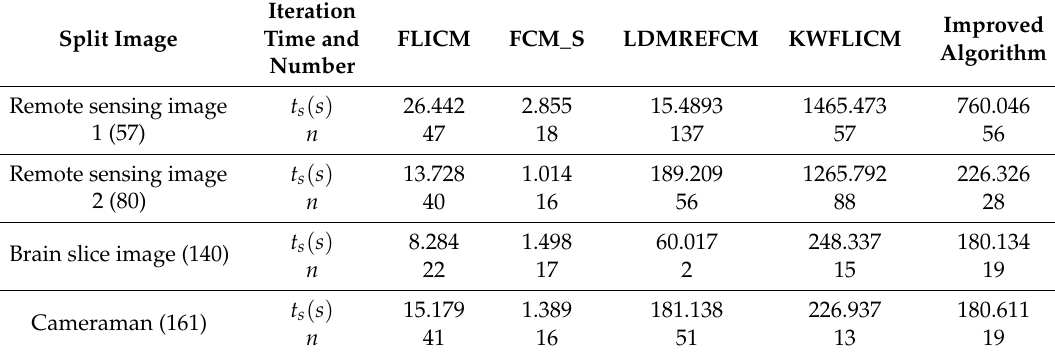
Table 3. Comparison of the iteration times and number of